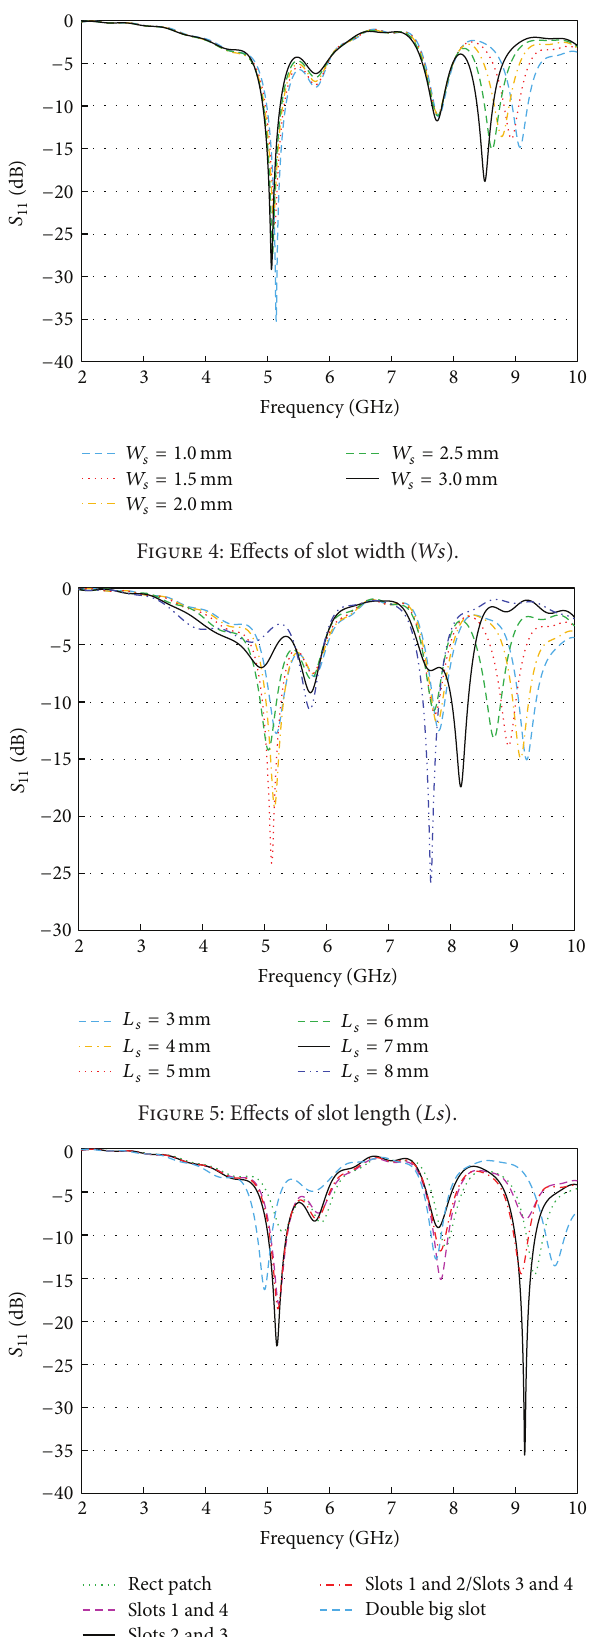
Figure 6: Effects of arrangements of different slots.